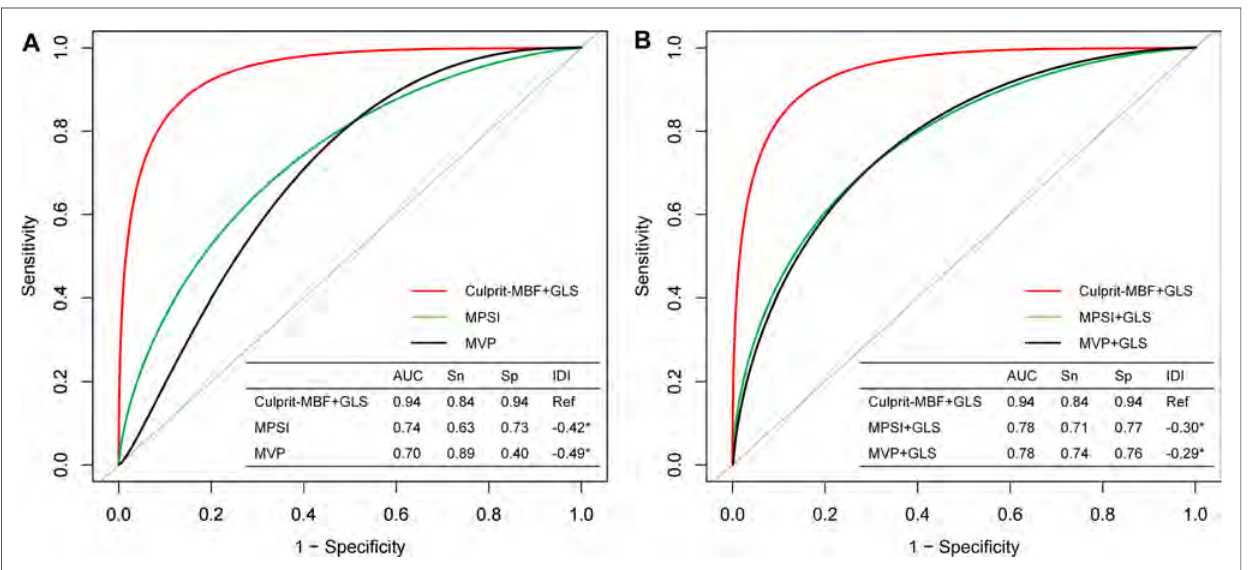
FIGURE 3 The discrimination of different models for MACE at 6-month follow-up. ( A ) Comparison of the proposed model with traditional visual qualitative analysis. ( B ) Comparison of the proposed model with the qualitative analysis+GLS model. MBF, microvascular blood fl ow; MPSI, myocardial perfusion score index; MVP, microvascular perfusion; Sn, sensitivity; Sp, speci fi city; IDI, Integrated Discrimination Improvement; *, P value<0.05.